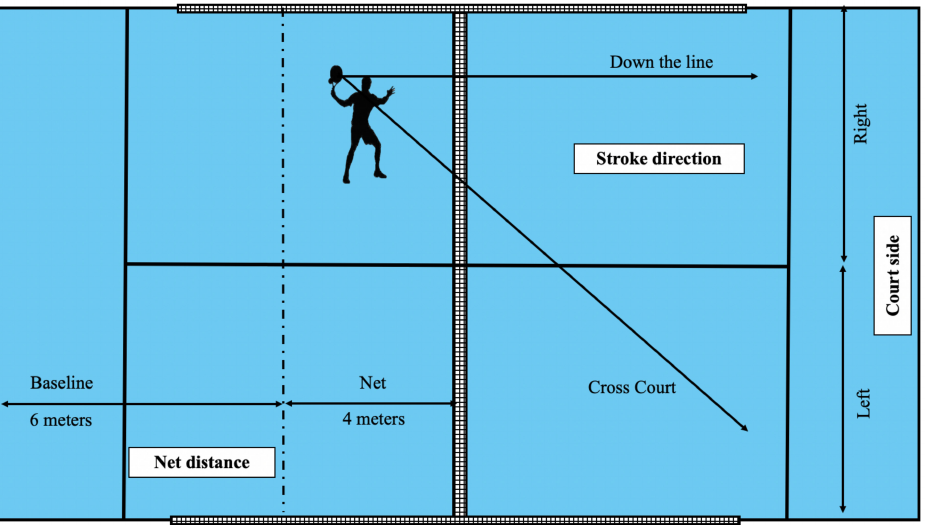
Figure 1. Net distance (baseline and net), playing side (right and left), and stroke trajectory (down the line or cross